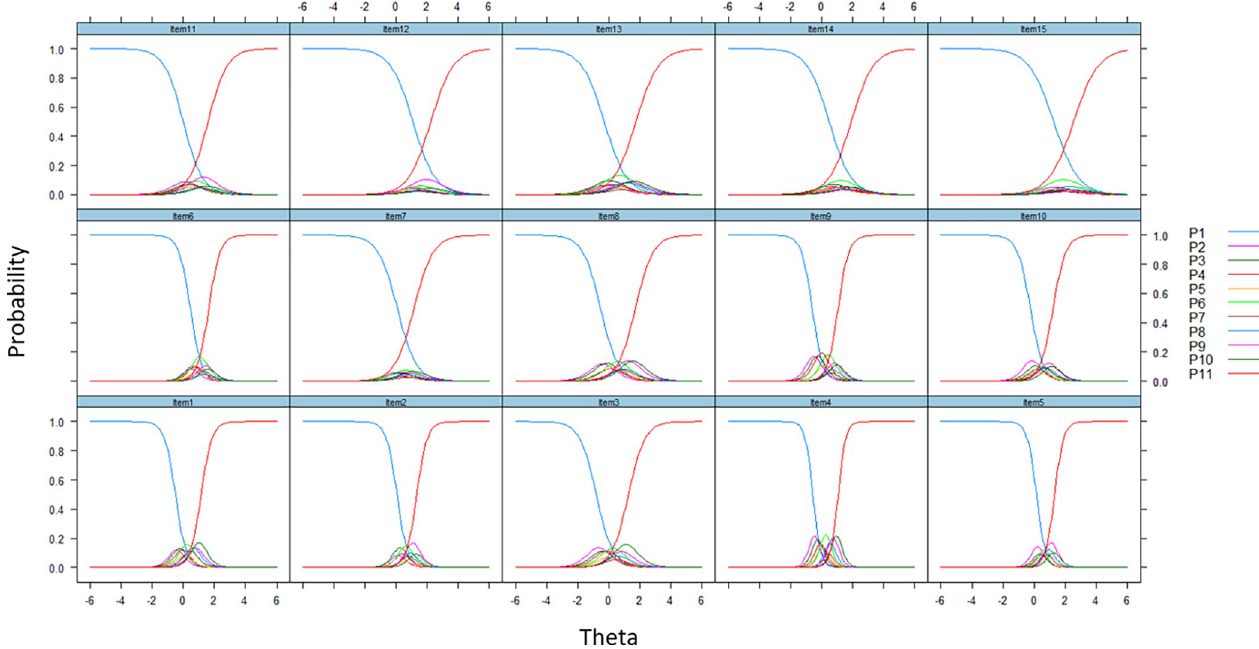
Fig 2. Disordered thresholds for initial analysis on 15 items with 11 response categories each displayed as 0-1-2-3-4-5-6-7-8-9-10.